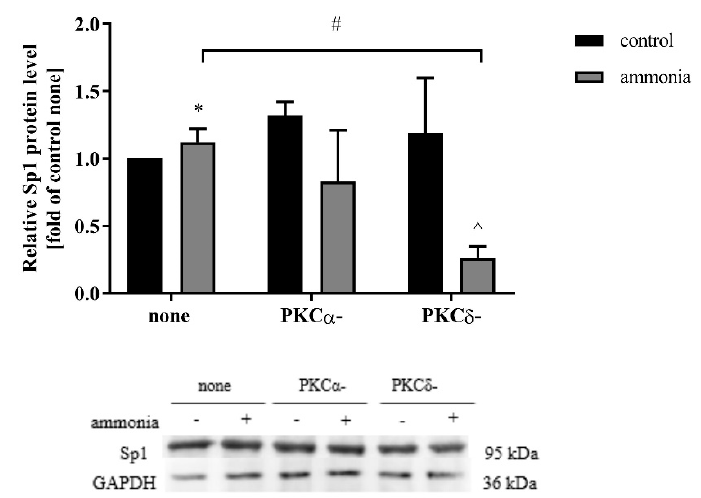
Figure 6. Sp1 protein level in astrocytes treated with 5 mM ammonia for 24 h and after silencing of PKC α (PKC α -) or PKC δ (PKC δ -) isoforms. Results are mean ± SD ( n = 4). (*) p < 0.05 vs. control none;